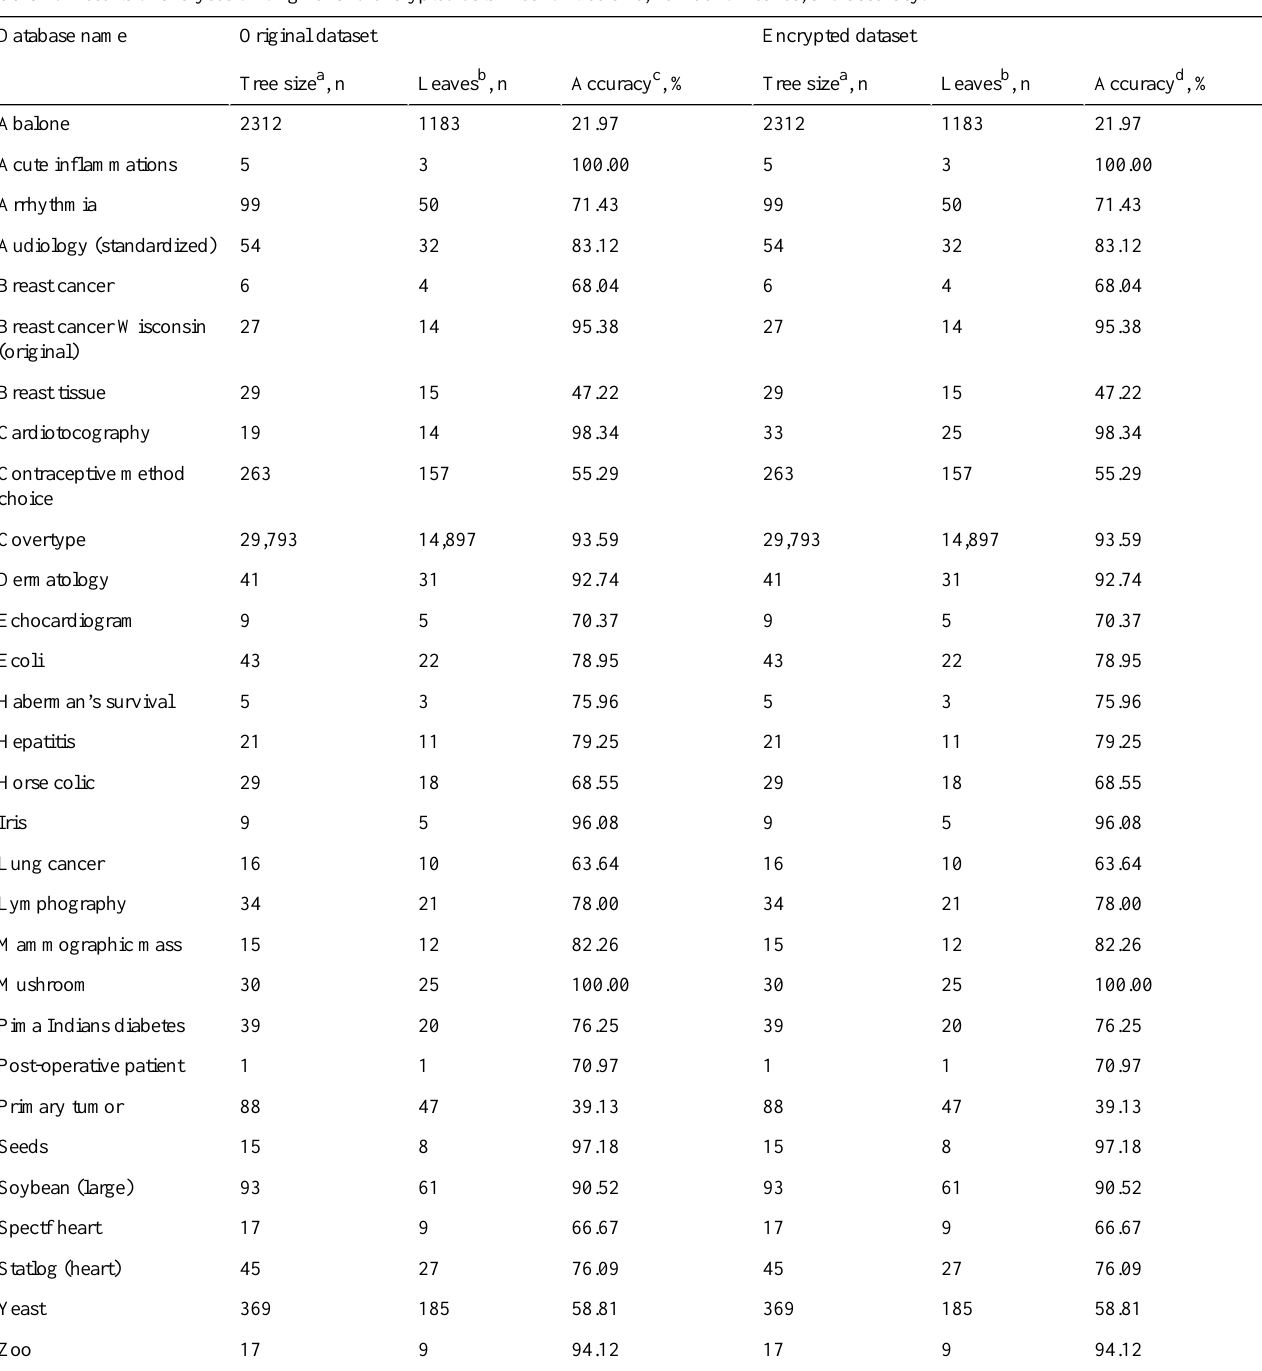
Table 1. Results of analyses on original and encrypted data files for tree size, number of leaves, and accuracy.